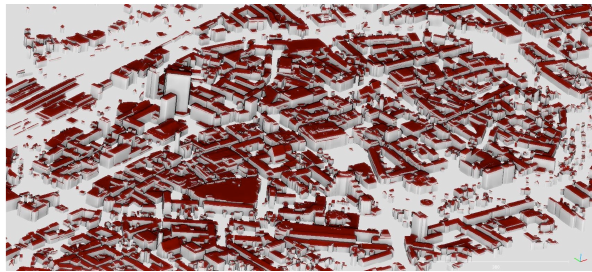
Figure 4. 3D building blocks (LOD2) automatically generated from oblique imagery.